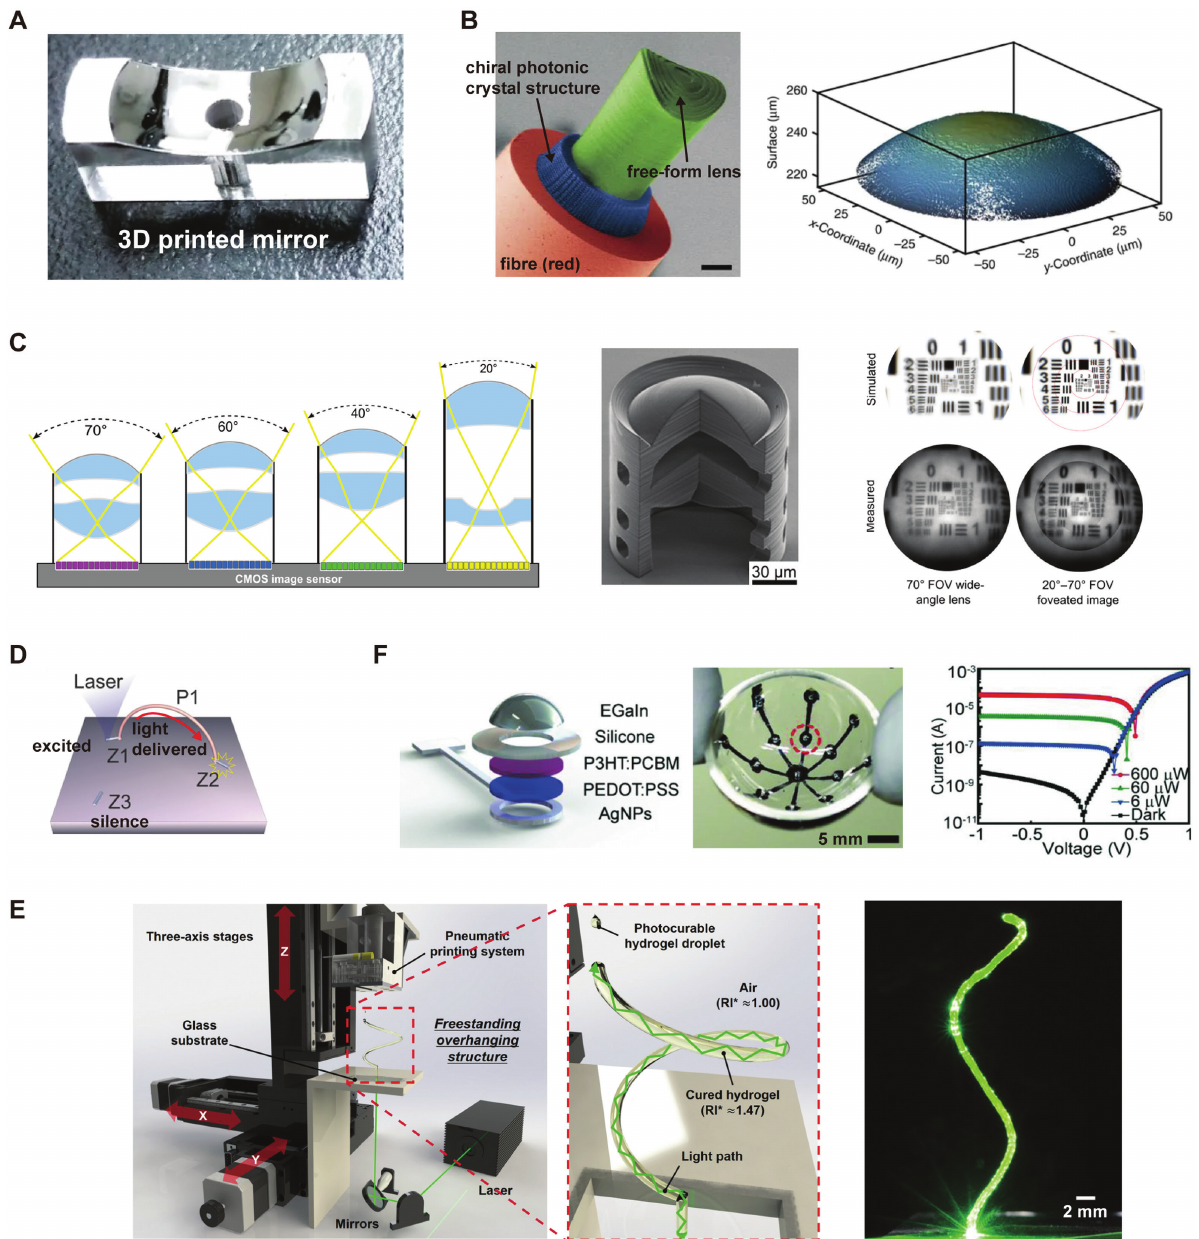
Figure 5: 3D printing for optical and optoelectronic components. (A) 3D-printed parabolic mirror after smoothing and aluminum deposition. Adapted from Ref. [71]. Copyright (2018) Nature Publishing Group. (B) Left: Scanning electron microscope (SEM) image of a sub-micrometer optical element printed onto a single-mode fiber (scale bars: 25 μ m). Right: Measured topography using optical interferometry of a spherical lens with a lens thickness of 250 μ m, a radius of curvature 85.77 μ m. Adapted from Ref. [72]. Copyright (2016) Nature Publishing Group. (C) Left: Four different FOV compound lenses on the same CMOS image sensor and the SEM image of a 3D-printed doublet lens. Right: Comparison of simulation and measurement images through a single compound lens with FOV of only a 70 ° (left), and with 20 ° , 40 ° , 60 ° , 70 ° (right). Adapted from Ref. [73]. Copyright (2017) AAAS. (D) Illustration explaining optical interconnection between two ZnO nanorods (Z1, Z2) through a polystyrene nanowire (P1). Adapted from Ref. [88]. Copyright (2016) John Wiley & Sons. (E) Left: Schematic view of the 3D printing system. The zoom-in part represents a 3D-printing method inspired by the light guide of an optical fiber. Right: Helical structure where light is guided and transmitted. Adapted from Ref. [75]. Copyright (2019) John Wiley & Sons. (F) Left: Schematic of the structure of the photodetector. Center: Photograph of the concentric photodetector array printed onto the inner surface of a hemispherical glass dome. Right: I-V characteristics of the photodetector onto the hemispherical glass dome. Adapted from Ref. [76]. Copyright (2018) John Wiley &